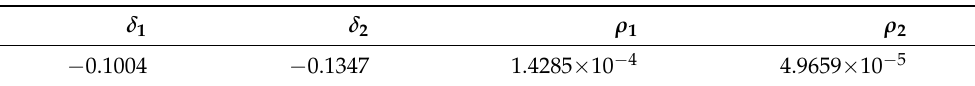
Table A1. Mortality Model